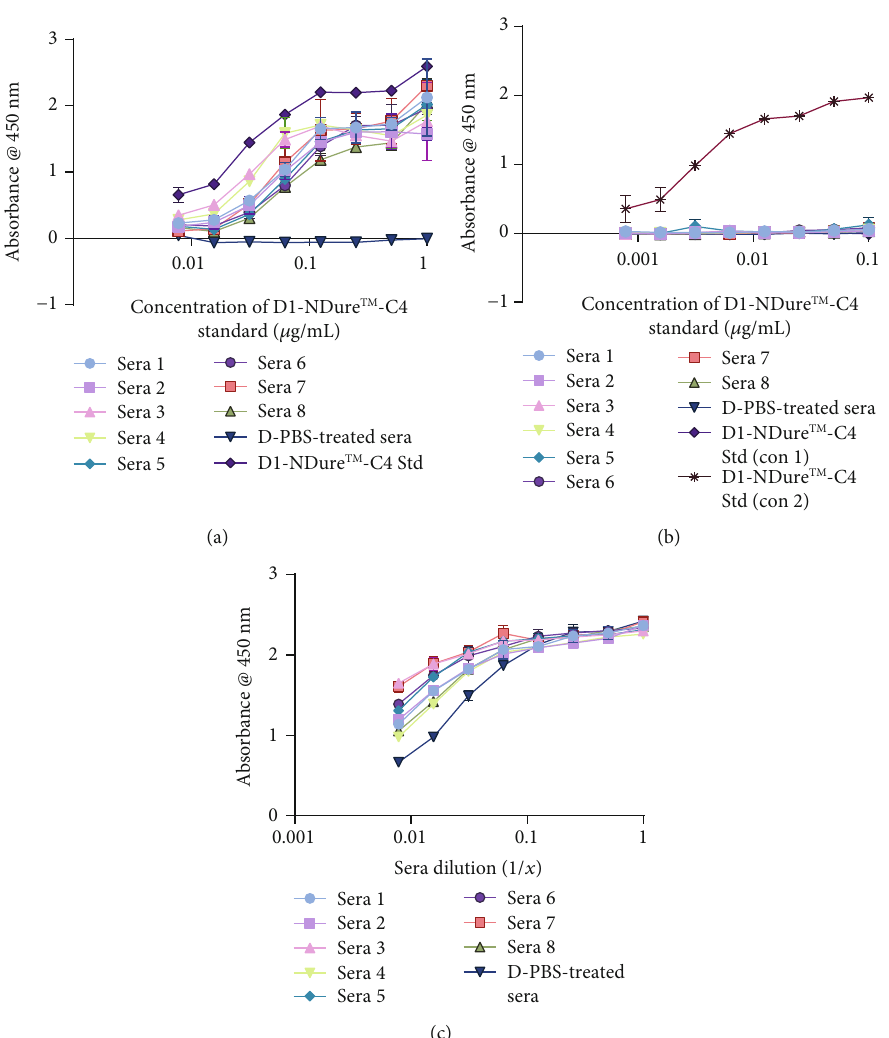
Figure 4: Detection and quanti fi cation of serum D1-NDure ™ -C4 and drug-speci fi c mouse ADA using direct-binding ELISA . (a) Detecting and quantifying serum D1-NDure ™ -C4 in 30 mg/kg D1-NDure ™ -C4-treated mice serum samples diluted at 1 :500 in sterile PBS, pH 7.4 prior to adding to designated ELISA wells. Serum D1-NDure ™ -C4 was detected and quanti fi ed in a direct-binding ELISA with wells coated with 2 μ g/mL hTNF- α , and secondary antibody detection was performed using an anti-poly-histidine-peroxidase antibody. Standard D1-NDure ™ -C4 (D1-NDure ™ -C4 Std) was used at a top known concentration of 1 μ g/mL. (b) Direct-binding ELISA